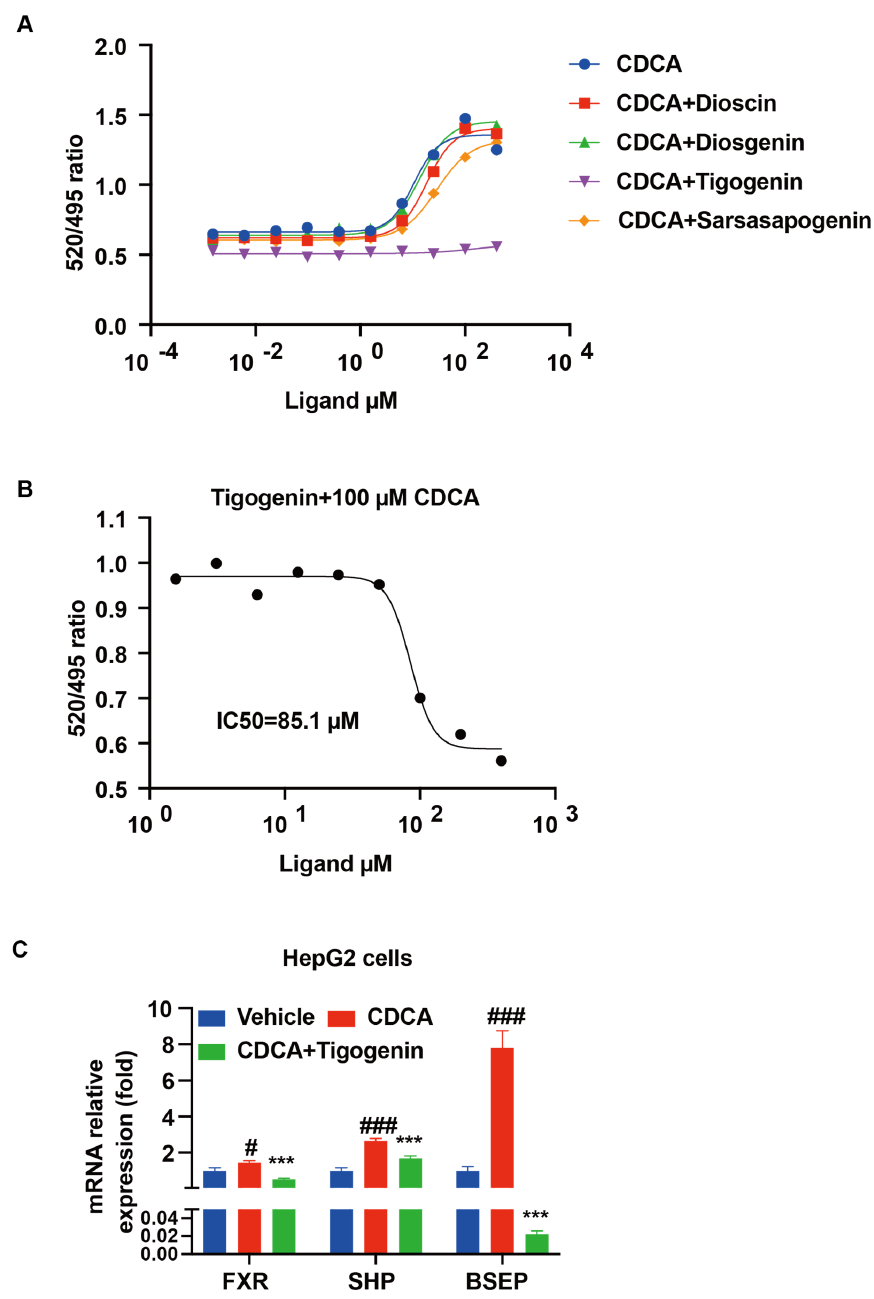
Figure 5. Effect of dioscin and its metabolites on FXR activation by CDCA: ( A ) Activation of FXR by CDCA in the presence of 100 µ M ligands (dioscin and its metabolites) to demonstrate the reversibility of binding. ( B ) TR-FRET FXR coactivator recruitment assay to assess whether tigogenin is a functional antagonist to CDCA (100 µ M) -mediated activation of FXR. ( C ) FXR target genes mRNA expression in HepG2 cells after treatment with CDCA alone or 20 µ M tigogenin with CDCA for 24 h. Data are presented as mean ± S.E.M. # p < 0.05, ### p < 0.001 vs. vehicle group, *** p < 0.001 vs. CDCA group. GraphPad Prism version 8.0 (GraphPad Software, San Diego, CA, USA) was used to fit the experimental data points to curves and to calculate EC 50 and IC 50